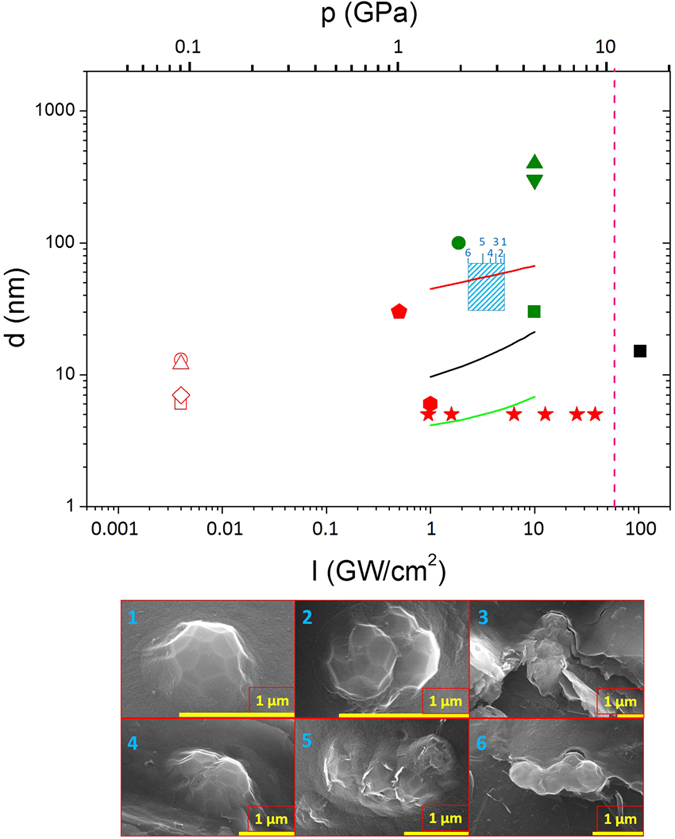
Experimental size of NDs as a function of laser intensity.The dashed-blue box represents the region in which the size of our single NDs crystals falls. It spans a range from 30 to 70 nm, centered around 50 nm, with laser intensities from 2.4 and 5.2 GW/cm2. Red points are taken from Sun56 (empty square), Hu57 (empty circle), Bai58 (empty diamond and empty triangle), Ferrari19 and Ren59 (hexagon and stars) and Mortazavi54 (pentagon) and correspond to ultrafine NDs produced with a 1064 nm laser. The black square was obtained with a 355 nm laser32. Finally, the green points correspond to diamond produced with a 532 nm, taken from282955 (circle, upward triangle and downward triangle) and Wang25 (square). Solid points correspond to ns laser pulses (5–20 ns pulse lengths), while empty points correspond to laser pulses of 0.4–1.2 ms. The pink dotted line indicates the threshold for the region of absolute stability of diamond at 4500 K, i.e. the temperature of the DGL triple point according to Bundy. The red, black and green curves represent the theoretical size of a single diamond crystal as a function of pressure for a supercooled liquid crossing the DL-lines continuations of Basharin39, Zazula41 and Ghiringhelli42, respectively (same colors of Fig. 4). The apparent discrepancy between theory and data may be explained by the fact that the biggest crystals experimentally observed consist of agglomerates of smaller crystals (polycrystals). The six numbered SEM images indicate that size of the clusters do not vary appreciably with our laser intensities. The yellow bar in the bottom panels is always 1 μm long.